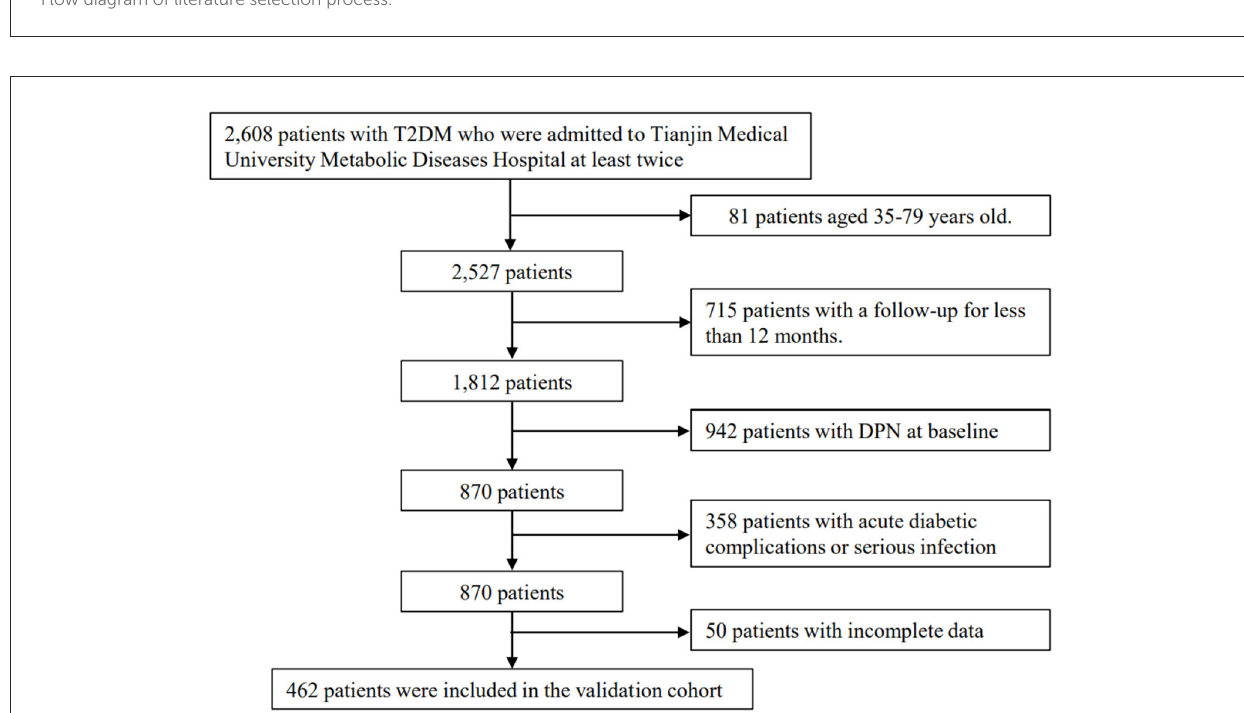
FIGURE1 Flow diagram of literature selection process.